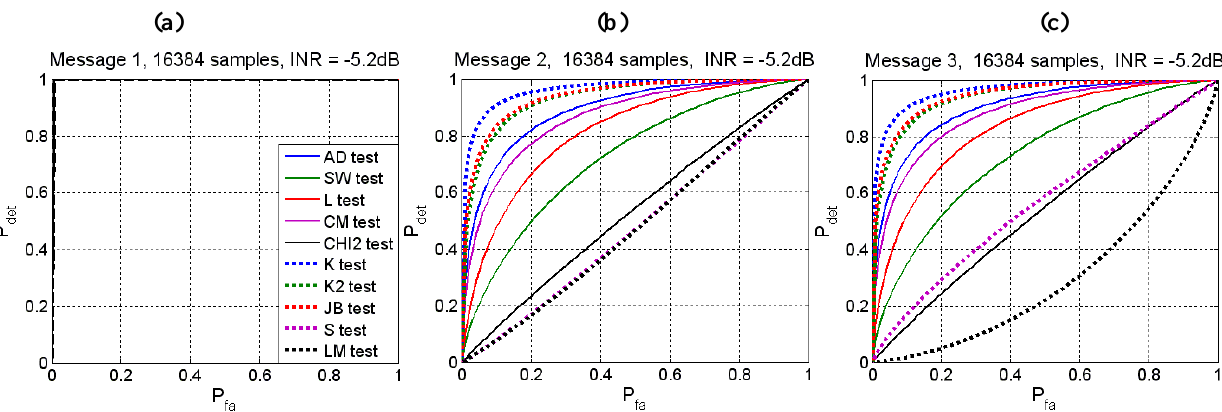
Figure 13. Normality test performance in the detection of a telegraphic interference signal. ROC curves of the different tests are presented in function of 3 different messages, setting the sample size to 16,384 and INR to − 5.2 dB. Message 1, is easily detectable for all the normality tests due to its elevated Messages 2 and 3, both compressed data (a zip and a jpg archives), Kurtosis seems to be the best detection algorithm. Results obtained from a Monte-Carlo set of 2 15